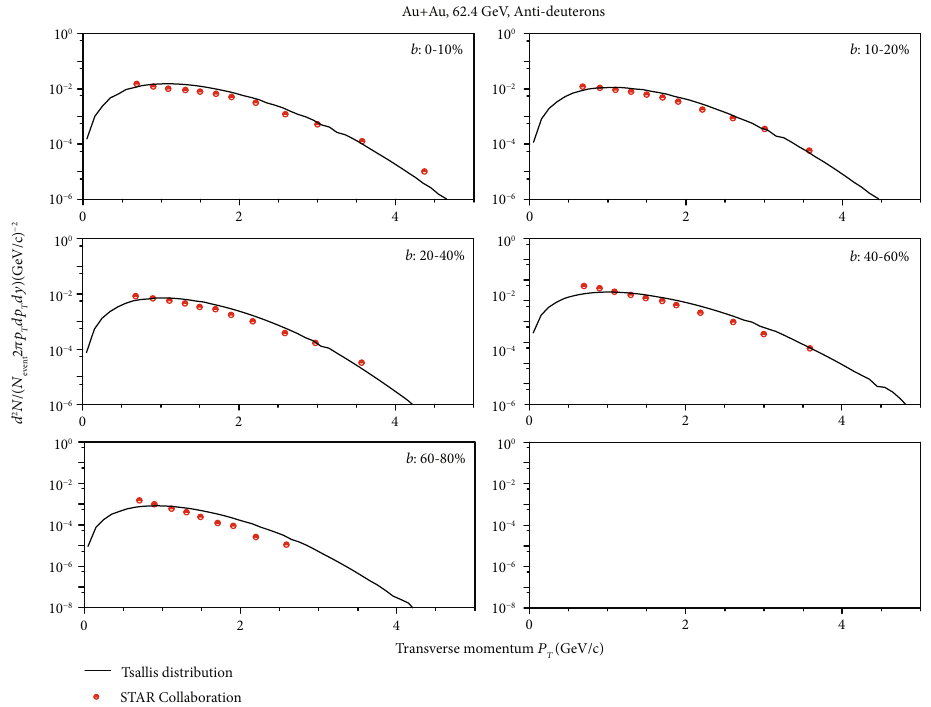
ffiffiffiffiffiffiffi p = 62 : 4 GeV for 0-10%, 10-20%, 20-40%, 40-60%, and s NN